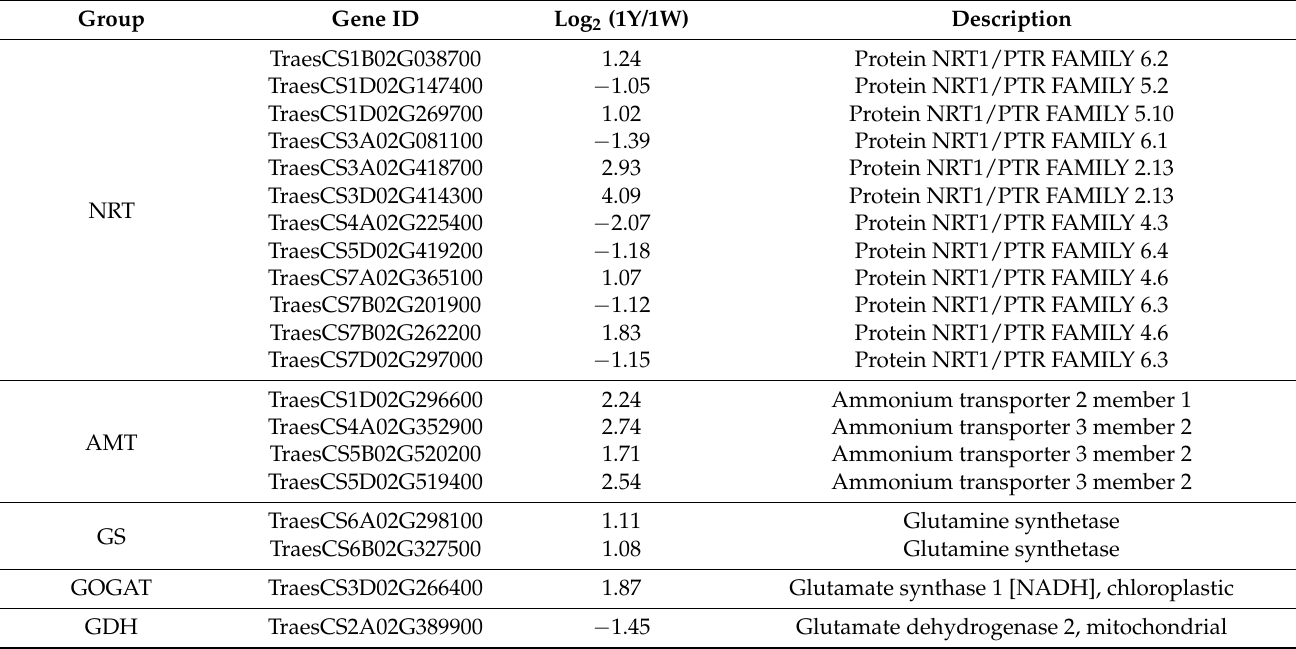
Table 2. Changes in the expression profiles of genes involved in nitrogen